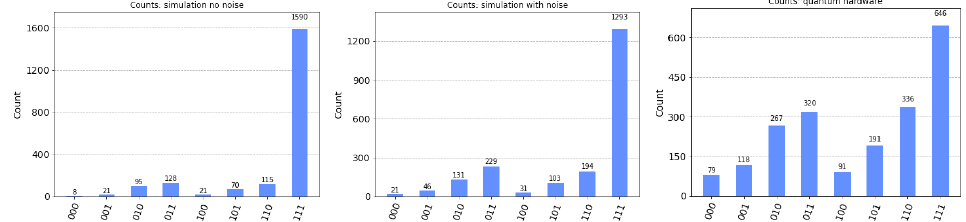
Figure 12. Counts distribution of 2048 shots for a simulated circuit with no noise ( left ) a simulated circuit with realistic noise ( center ) and a noisy quantum circuit ( right